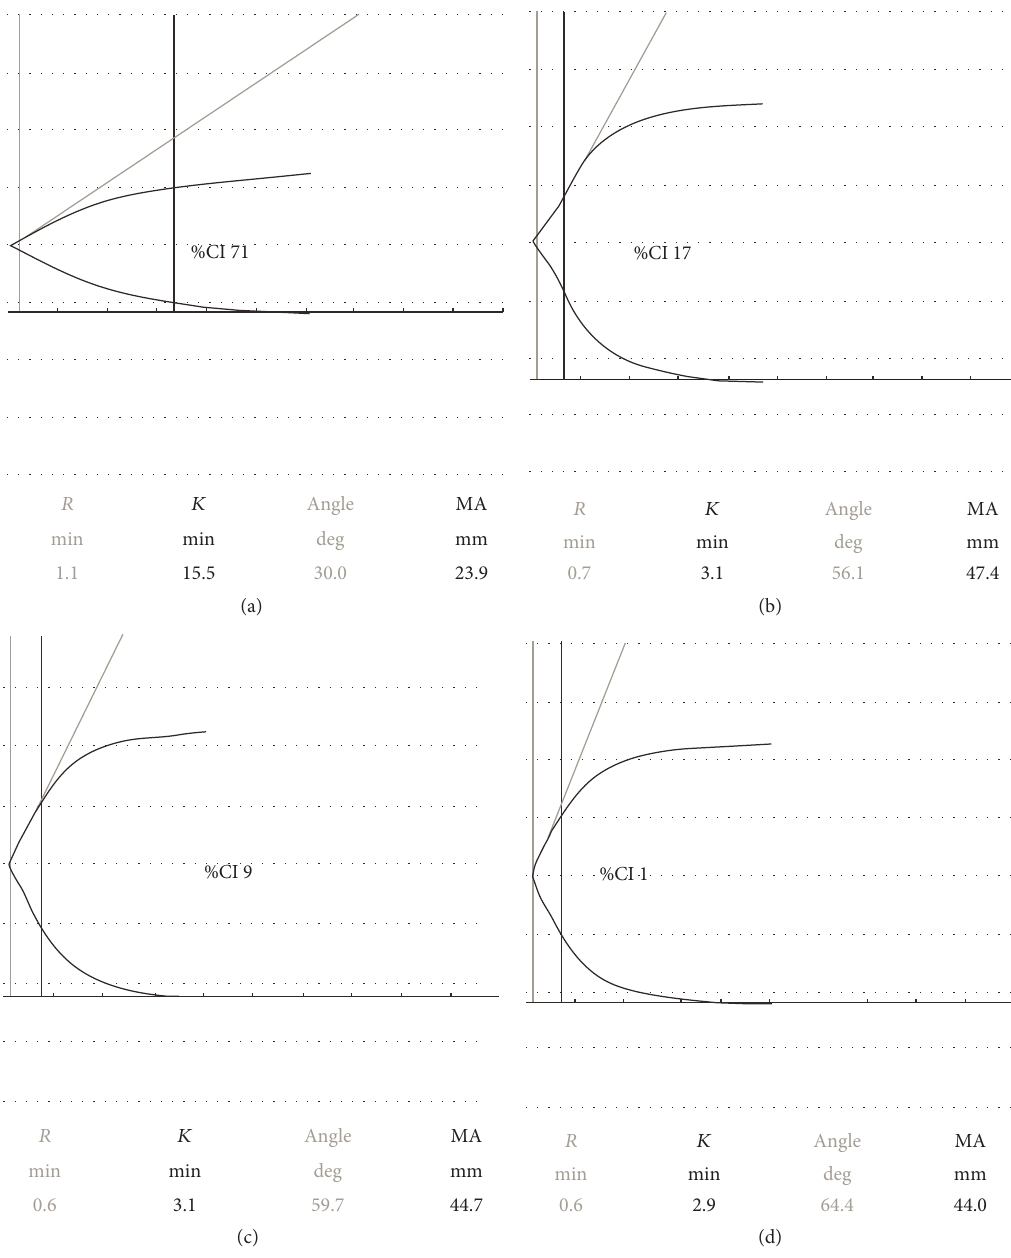
Figure 1: Short thromboelastography traces showing adequate response to aspirin 150mg daily and hyporesponse to P 2 Y 12 inhibitors in